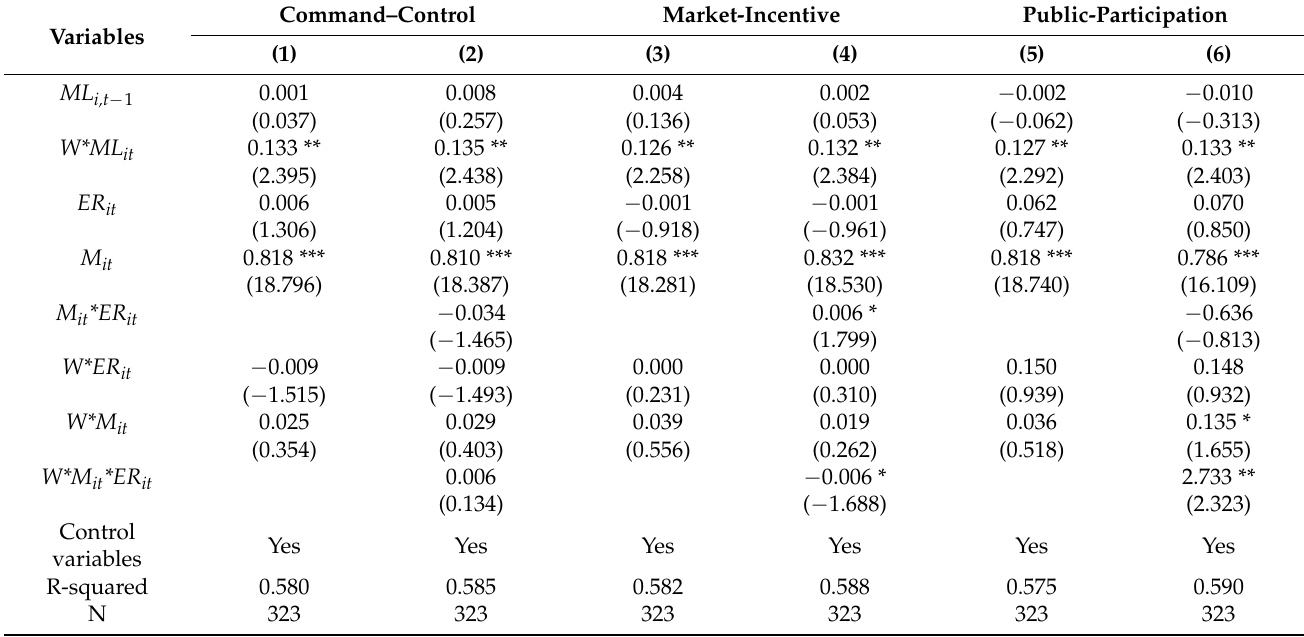
Table 10. The moderating results of technical change in the central and western